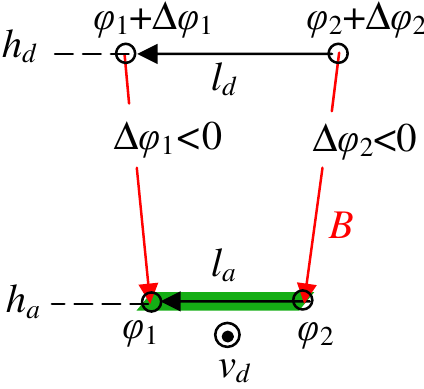
Fig. 12. Schema which illustrates the distribution of electric poten- tials along the magnetic lines associated with the